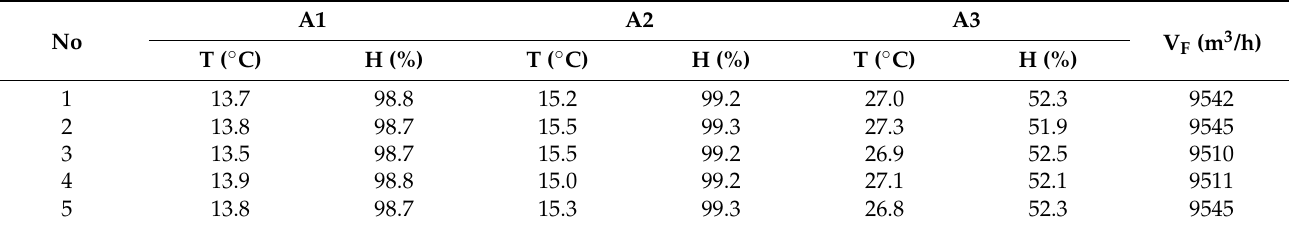
Table 13. Air side measurement result (five times).